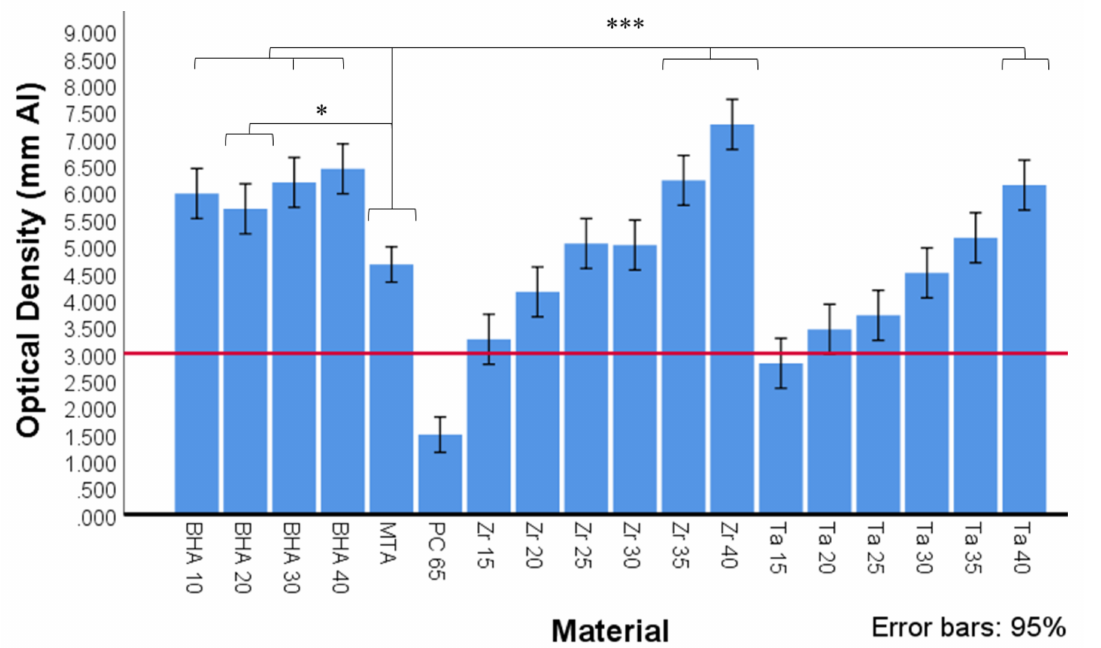
Figure 4. Optical density expressed in equivalent thickness of aluminium (Al) of MTA, Portland cement (PC) and PC with different radiopacifiers, as determined by ImageJ software (n = 3). All BHA groups contained 35% ZrO 2 . Red line depicts ISO 9917-1 (2007) cut off at 3 mm Al equivalent thickness. Significant differences between MTA and BHA 10%, BHA 30% and BHA 40%, ZR 35%, Zr 40% and Ta40 (*** p < 0.001) and MTA and BHA 20% (* p < 0.05).